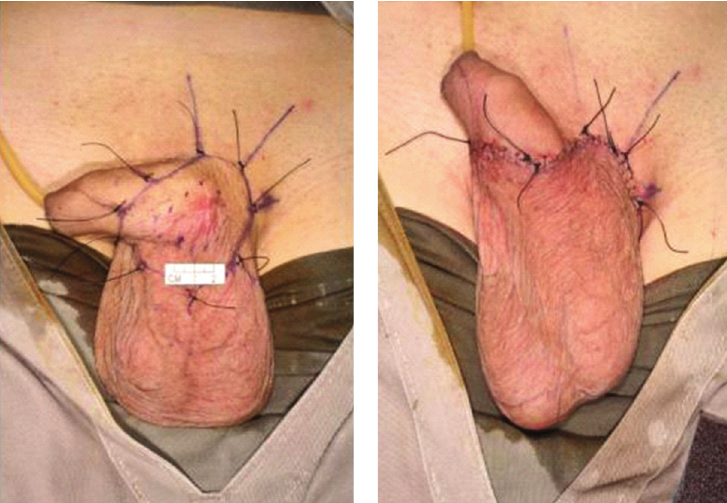
Figure 2: (Left) Small tumour involving penoscrotal region. The lesion was excised with 2 cm margins. (Right) Primary closure of resultant defect was possible utilizing the redundant scrotal